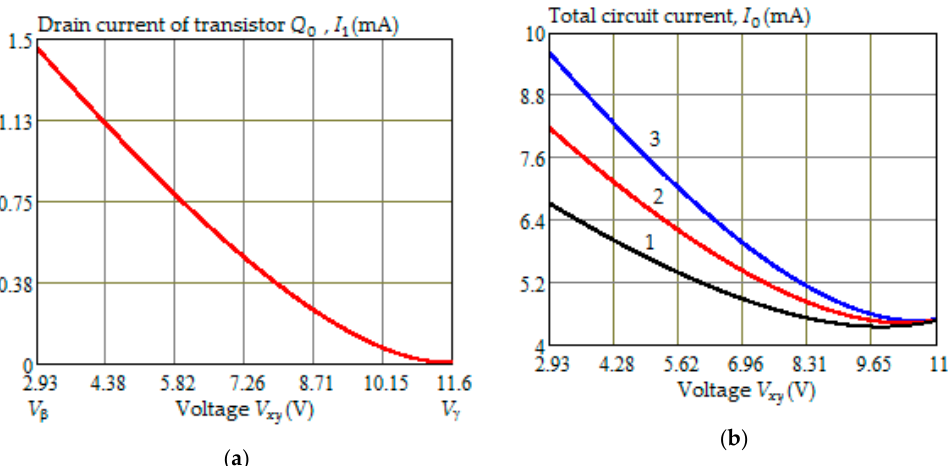
Figure 2. ( a ) Dependence of the drain current 𝐼 (cid:2869) versus voltage 𝑉 (cid:3051)(cid:3052) ; ( b ) Dependence of the total current 𝐼 (cid:2868) versus voltage 𝑉 (cid:3051)(cid:3052) in the negative differential resistance region when 𝑛 = 4 (curve 1), 𝑛 = 5 (curve 2), and 𝑛 = 6 (curve 3).